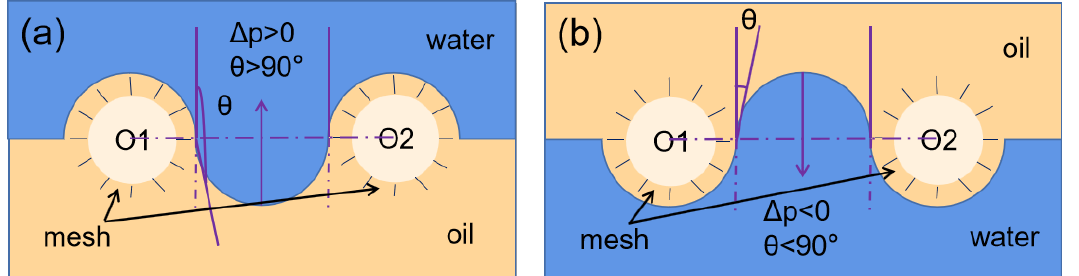
Figure 10. Principle of oil – water separation. (a)Before oil-water separation, (b) After oil-water separation